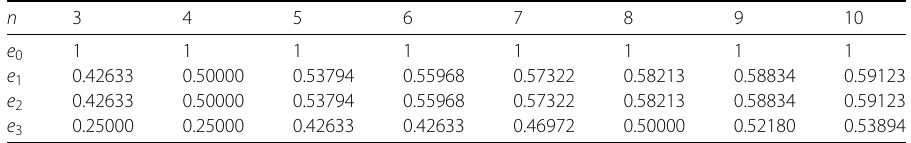
Table 3 Eigenvalues of polynomial (i.e., μ (cid:2) +1 = 1) subdivision matrix with valence n